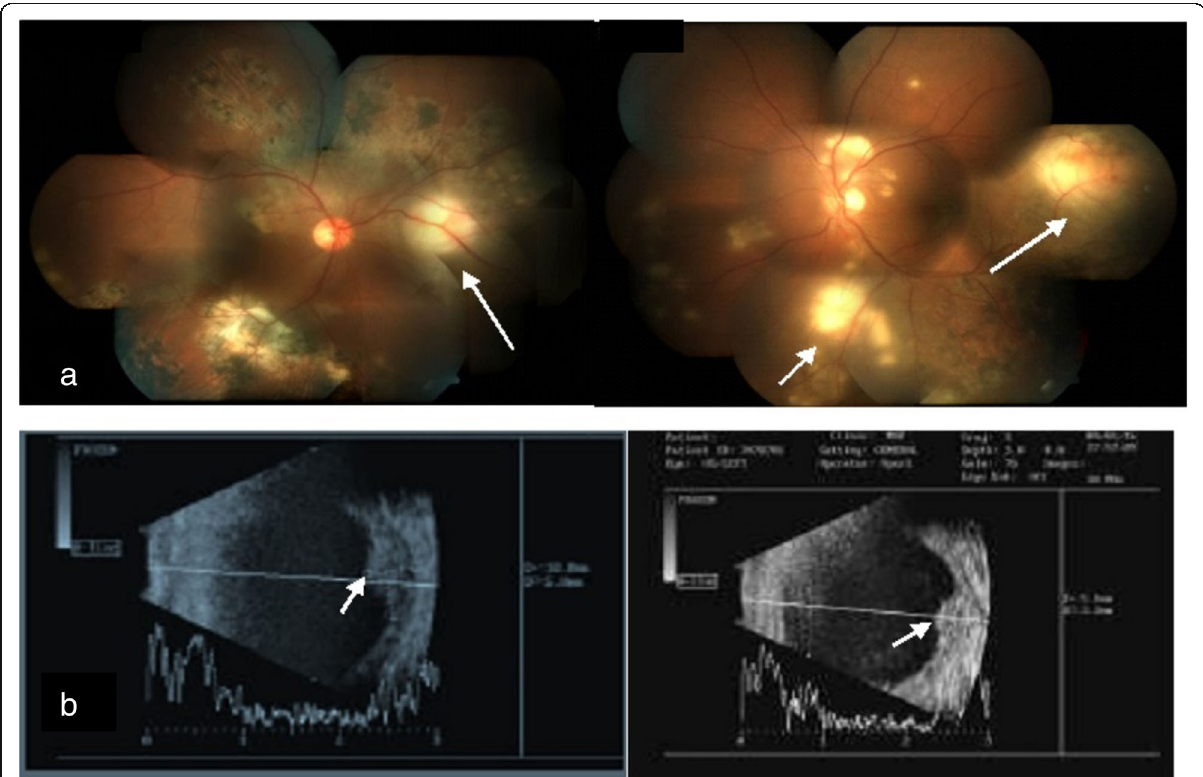
Fig. 1 a Fundus photograph of both eyes at presentation showing multiple subretinal abscesses with serpiginous-like choroiditis. b Corresponding B-scan ultrasonography showing retino-choroidal elevations suggestive of multiple sub-retinal abscesses in both